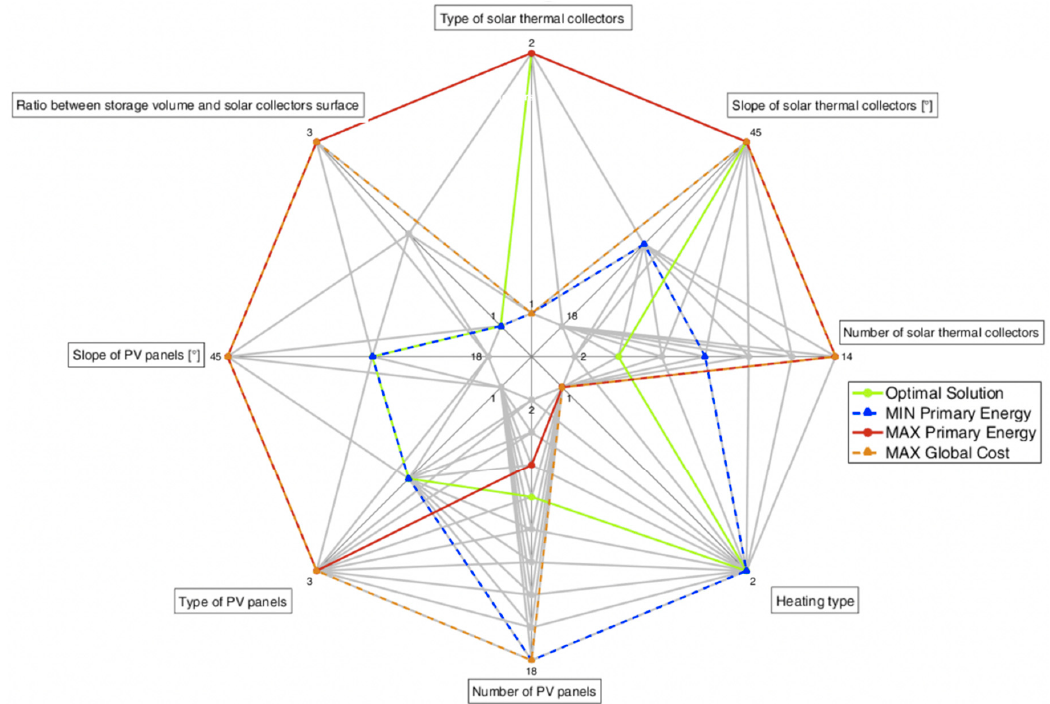
Figure 10. Design configuration networks: financial objective, sequential optimization, energy supply.